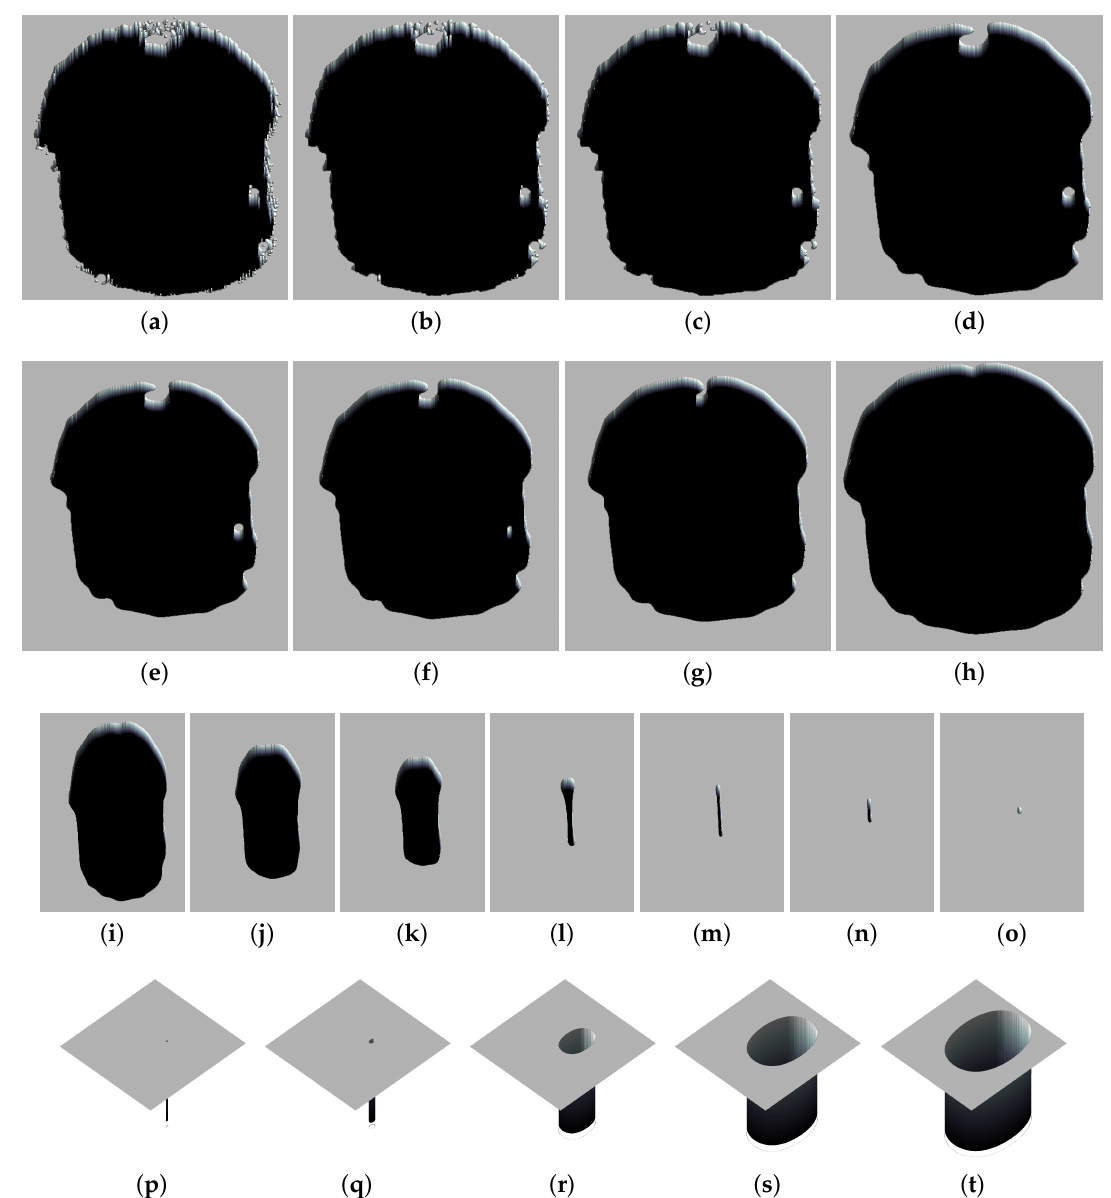
Figure 5. Steps of the RD-based laser spot algorithm applied to the image sample19 : ( a – d ) first stage of the algorithm, where a contraction phase smoothes all of the noisy contour; ( e – h ) second stage, where an expansion phase removes undesirable isolated spots that are interpreted as noise; ( i – o ) third stage where an cotraction phase reduces its size until the supposed laser spot center; ( p – t ) final and extra stage that reconstructs the expected circular